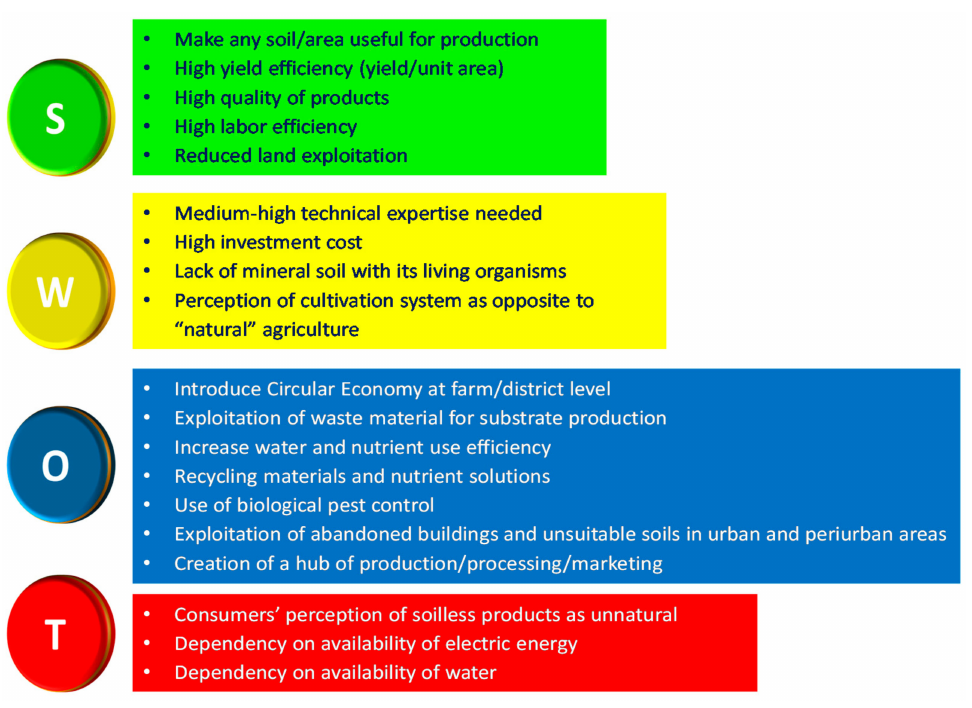
Figure 3. SWOT analysis related to the adoption of soilless systems in horticultural production. S, strengths; W, weaknesses; O, opportunities; T, threats.